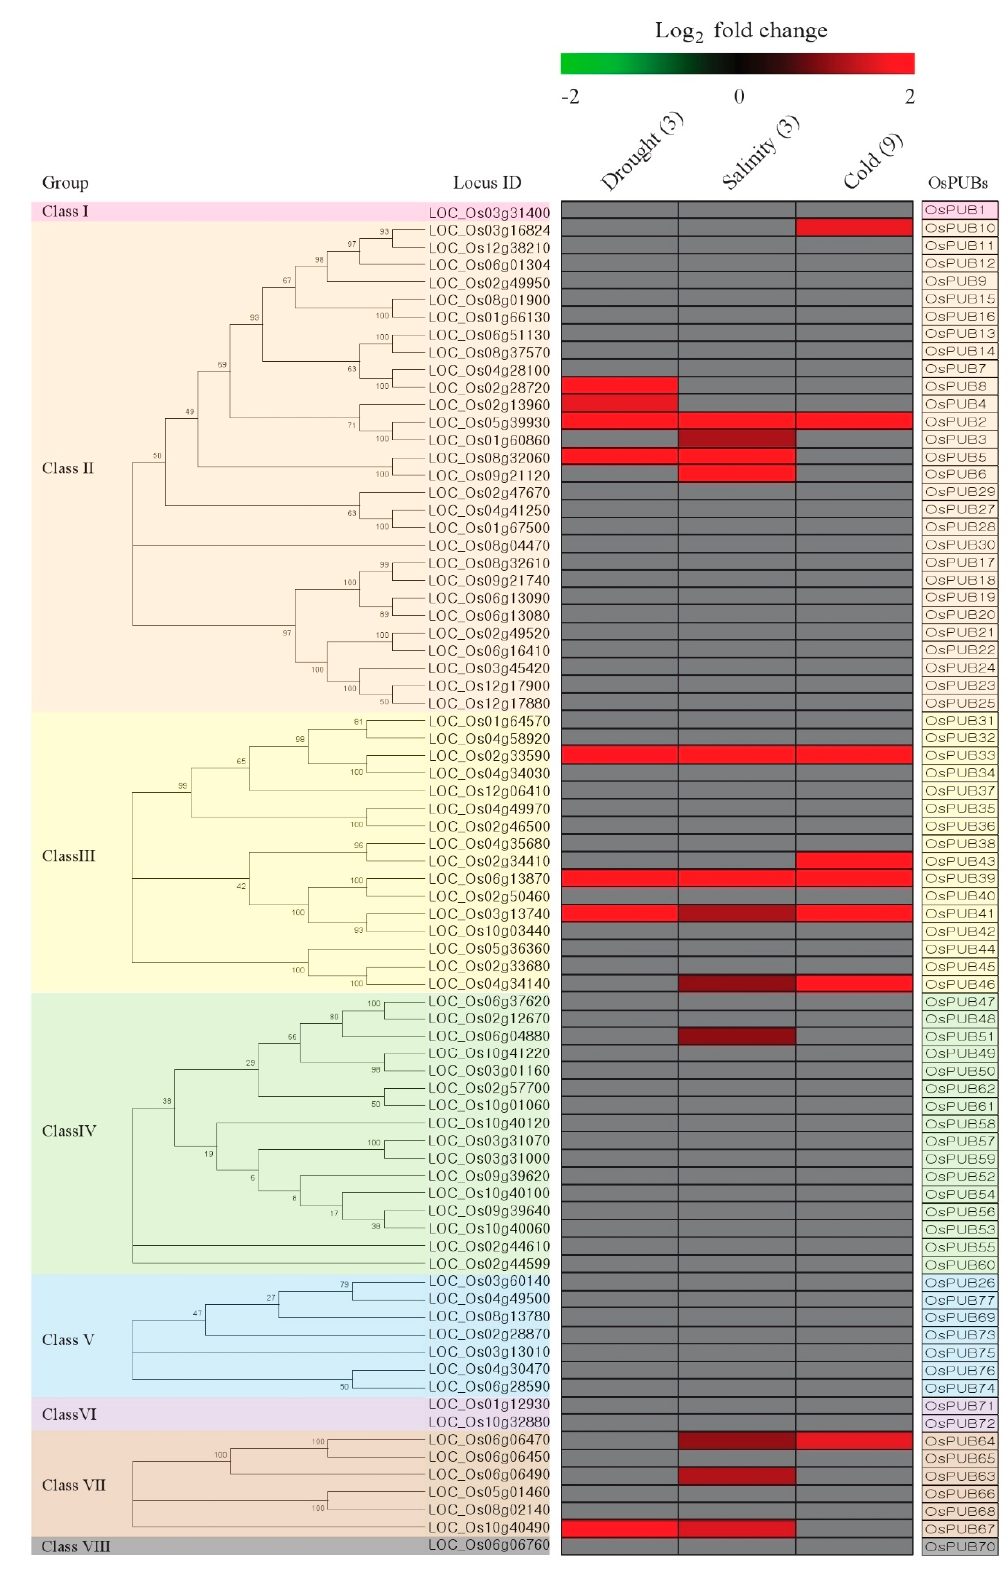
Figure 1. Meta-analysis of OsPUB genes expression patterns using drought- salinity- and cold-treated microarray data. On the left side of the heat-map is a phylogenetic tree for each class. Green, low level of log 2 intensity; red, high level; gray, t -test p -value > 0.01 or enrichment values of <1 (log 2 )-fold.